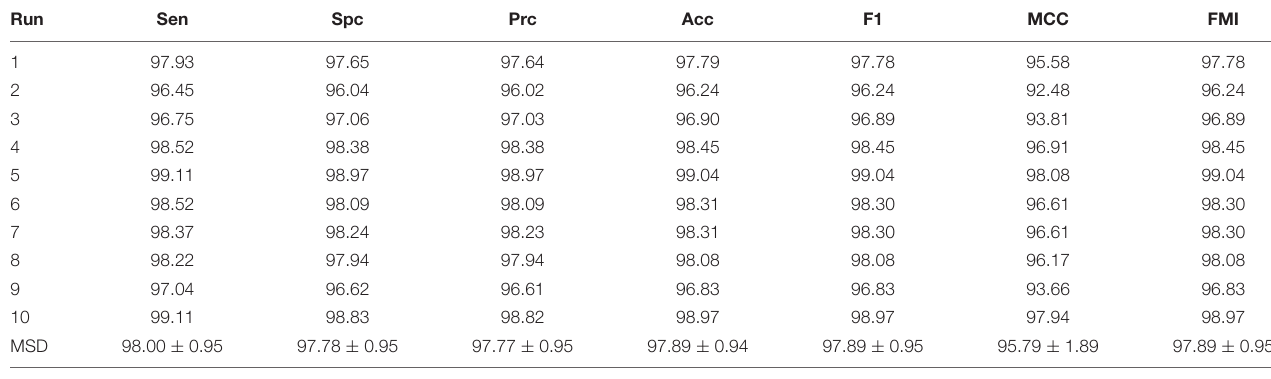
TABLE 5 | Results of 10 runs of proposed BWF-FAGA algorithm.